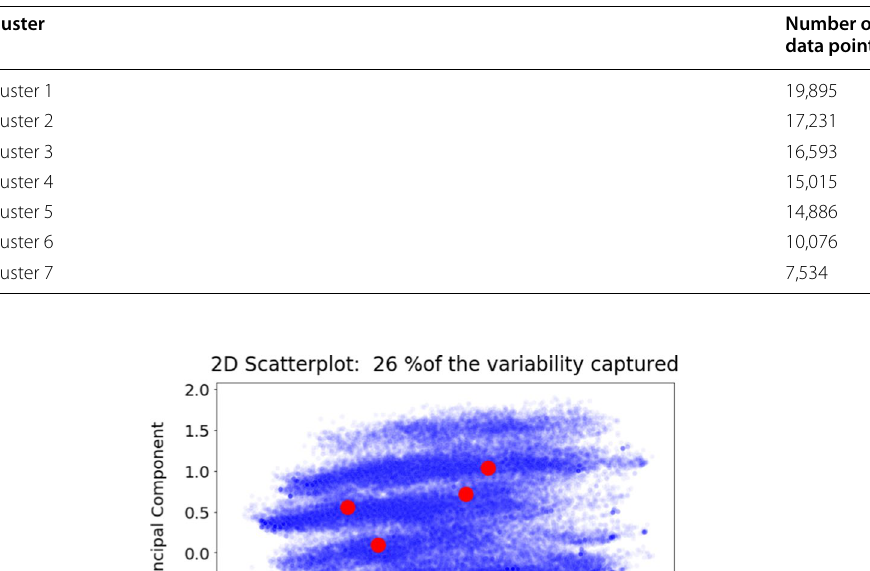
Table 4 Number of data points in each cluster